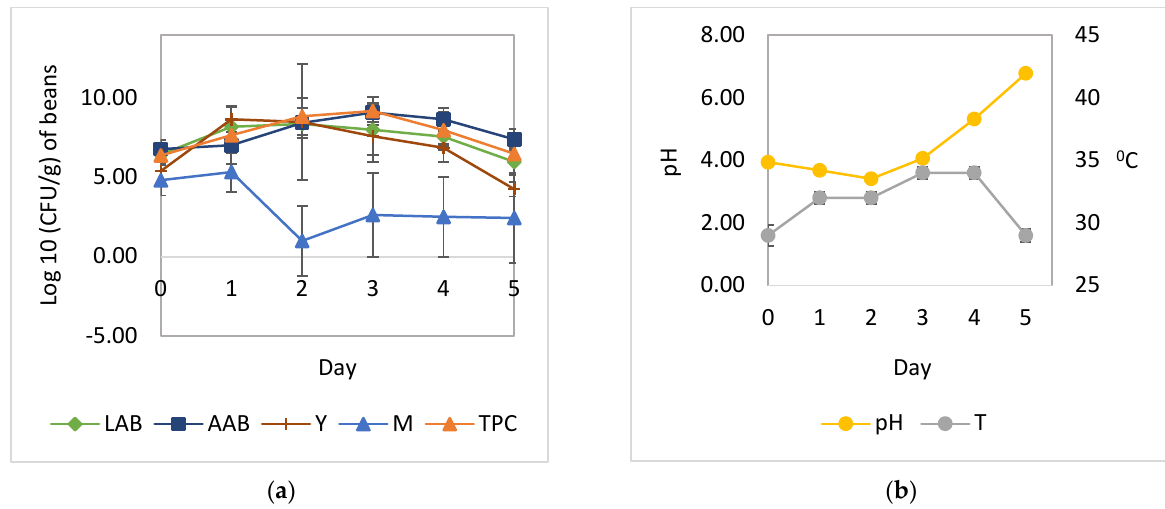
Figure 1. Microbial growth patterns and changes in pH and temperature during the natural fermentation of cocoa beans: ( a ) growth of yeast, LAB, AAB, and mold; ( b ) temperature and pH. LAB, total lactic acid bacteria; AAB, total acetic acid bacteria; Y, total yeast; M, total mold; TPC, total plate count; pH, pH pulp; T, temperature.